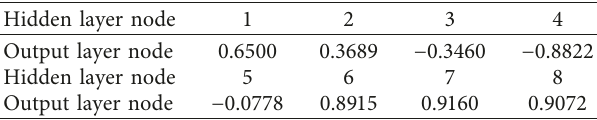
Table 4: Connection weight table of hidden layer nodes and output layer